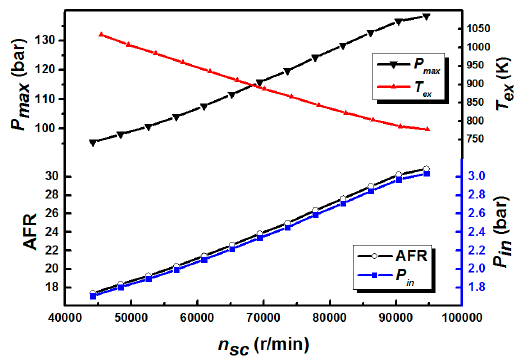
Figure 2. The influence of n sc to p max , T ex , AFR, and p in .